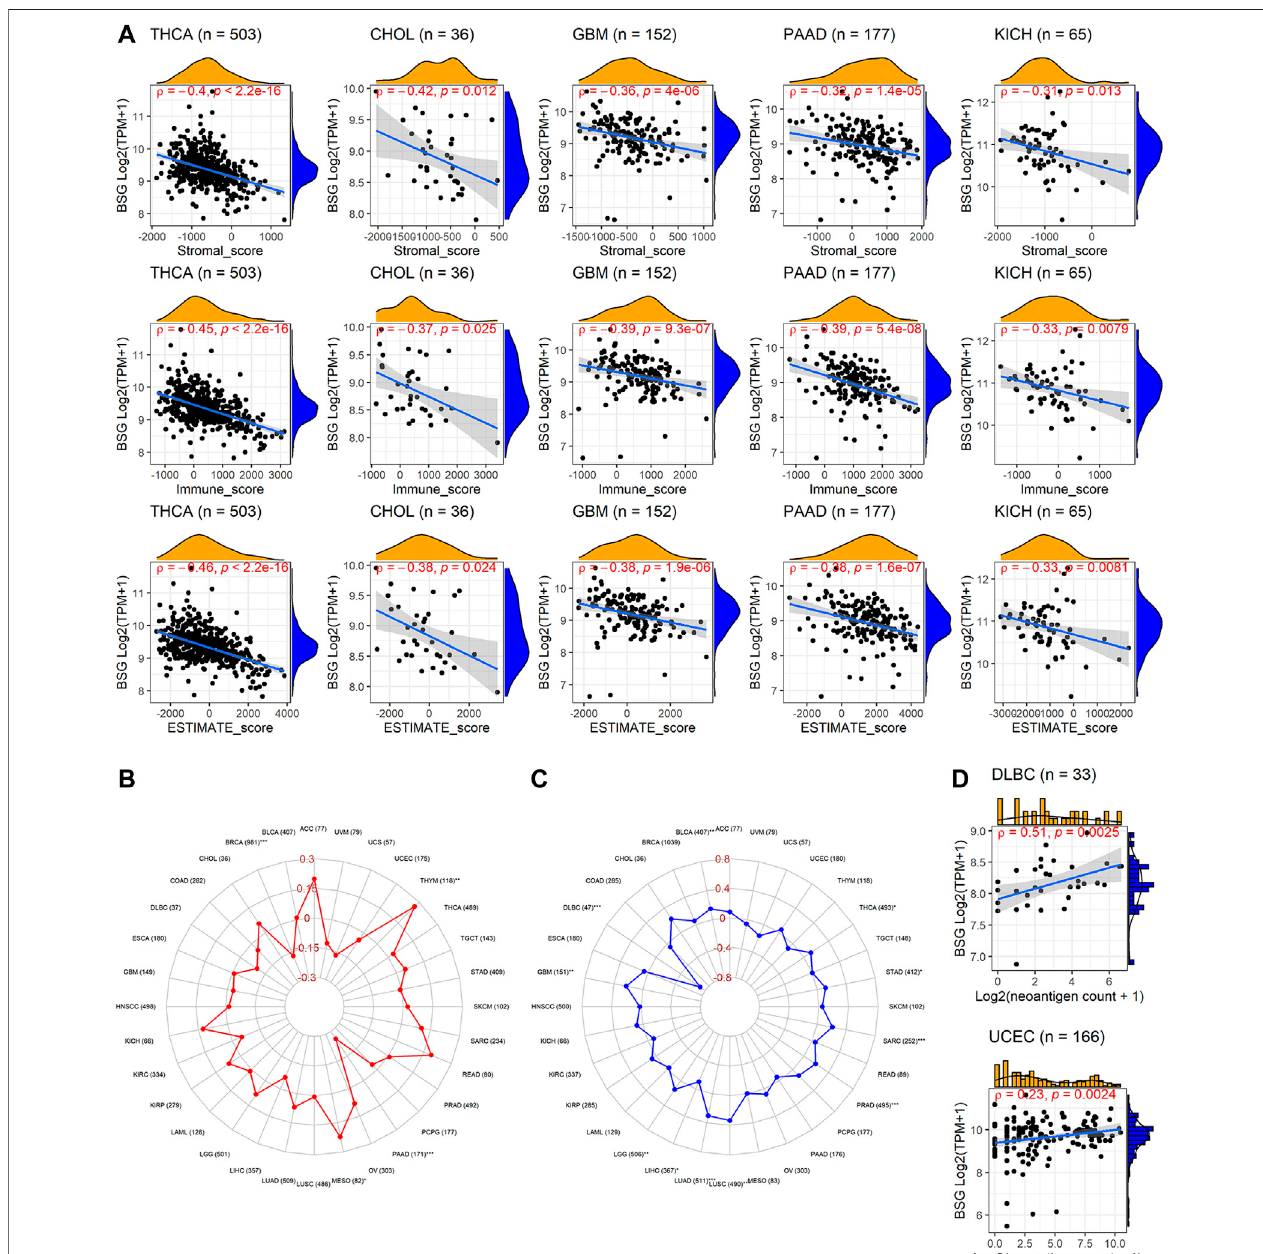
FIGURE 8 | Relevance of BSG expression with immune microenvironment scores, tumor mutational burden, microsatellite instability, and neoantigen. (A) BSG expression was positively correlated with all fi ve cancers ’ immune, stromal, and estimate scores. (B – C) BSG expression demonstrates distinct (positive or negative) correlation with tumor mutational burden and microsatellite in various cancers. (D) BSG expression is negatively associated with the count of neoantigens in speci fi c cancers. The Spearman correlation coef fi cient follows the letter “ ρ . ” In (A,C) , the value in parentheses (e.g., “ n = 503 ” for THCA in A, and “ 77 ” for AA in (B) ) represents the number of samples. ACC, adrenocortical carcinoma; BLCA, bladder cancer; BRCA, invasive breast carcinoma; CHOL, cholangiocarcinoma; COAD, colon adenocarcinoma; DLBC, lymphoid neoplasm diffuse large B-cell lymphoma; ESCA, esophageal carcinoma; GBM, glioblastoma multiforme; HNSCC, head and neck squamous cell carcinoma; KICH, kidney chromophobe; KIRC, kidney renal clear cell carcinoma; KIRP, kidney renal papillary cell carcinoma; LAML, acute myeloid leukemia; LGG, brain lower grade glioma; LIHC, liver hepatocellular carcinoma; LUAD, lung adenocarcinoma; LUSC, lung squamous cell carcinoma; MESO, mesothelioma; OV, ovarian serous cystadenocarcinoma; PAAD, pancreatic adenocarcinoma; PCPG, pheochromocytoma and paraganglioma; PRAD, prostate adenocarcinoma; READ, rectum adenocarcinoma; SARC, sarcoma; SKCM, skin cutaneous melanoma; STAD, stomach adenocarcinoma; TGCT, testicular germ cell tumors; THCA, thyroid carcinoma; THYM, thymoma; UCEC, uterine corpus endometrial carcinoma; UCS, uterine carcinosarcoma; UVM, uveal melanoma.